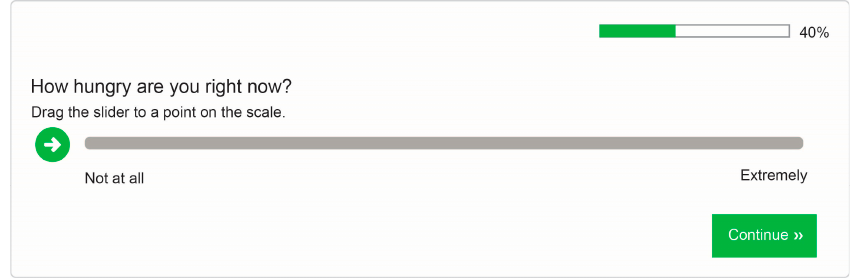
Figure 1. A digital visual analog scale to measure hunger in